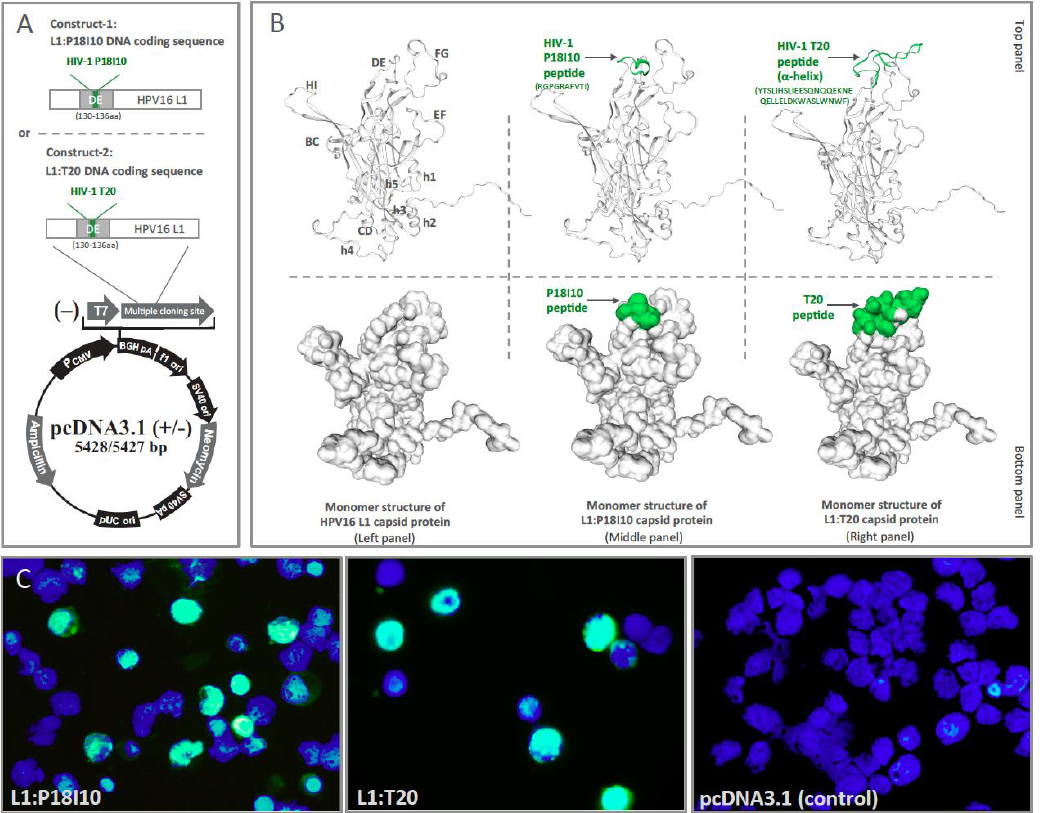
Figure 1. L1:P18I10 and L1:T20 immunogen design and construction of chimeric HPV:HIV VLPs by using 293F expression system. ( A ) The chimeric L1:P18I10 and L1:T20 DNA coding sequence were cloned into pcDNA3.1+ expression vector, respectively, for transient transfection in 293F cells. ( B ) Prediction of monomer structures of HPV16 L1 and chimeric HPV:HIV capsid proteins by using the SWISS-model server. HPV16 major capsid protein L1 (7cn2.1.R) was selected as the structural template to build the HPV16 L1 (left panel), L1:P18I10 (middle panel) and L1:T20 (right panel) capsid protein homology modeling. Secondary structural elements of HPV16 L1 capsid protein are labeled, with letters h1–h5 for the 5 α-helices. Loops of HPV16 L1 capsid protein between strands are labeled BC, CD, DE, EF, FG and HI. Secondary structural elements of HIV-1 P18I10 and T20 peptides L1 are labeled by the arrows (top panel). The part of the P18I10 and T20 peptide that protrudes above the surface of the HPV16 L1 capsid protein are indicated by the arrows (bottom panel). ( C ) Immunofluorescence staining of L1 protein in 293F cells. The following pDNA.L1:P18I10 (left), pDNA.L1:T20 (middle) and pDNA.without insertion (right) were trans- fected in 293F cells. The transfected cells were probed with anti-HPV16 L1 mAb and detected with anti-mouse IgG-FITC (green channel) . Cell nuclei were stained with DAPI (blue channel). Immu- nofluorescence images were merged by using Adobe Photoshop. 3.2. Purification of L1:P18I10 and L1:T20 VLPs by Using Chromatographic Methods The chimeric L1:P18I10 and L1:T20 proteins were produced by using 293F expres- sion system. The capture, intermediate purification, polishing (CiPP) strategy to develop our chromatographic purification protocol is shown in Figure 2A. Flowthrough (FT) in each purification step were collected and the level of L1 protein expression was detected